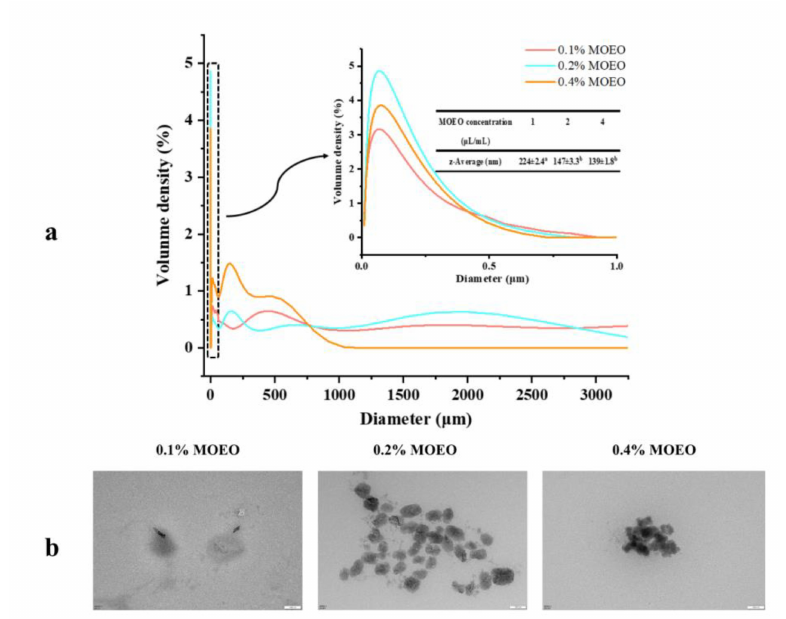
Figure 2. ( a ) Droplet size distribution and ( b ) transmission electron microscopy of Melissa officinalis L. essential oil